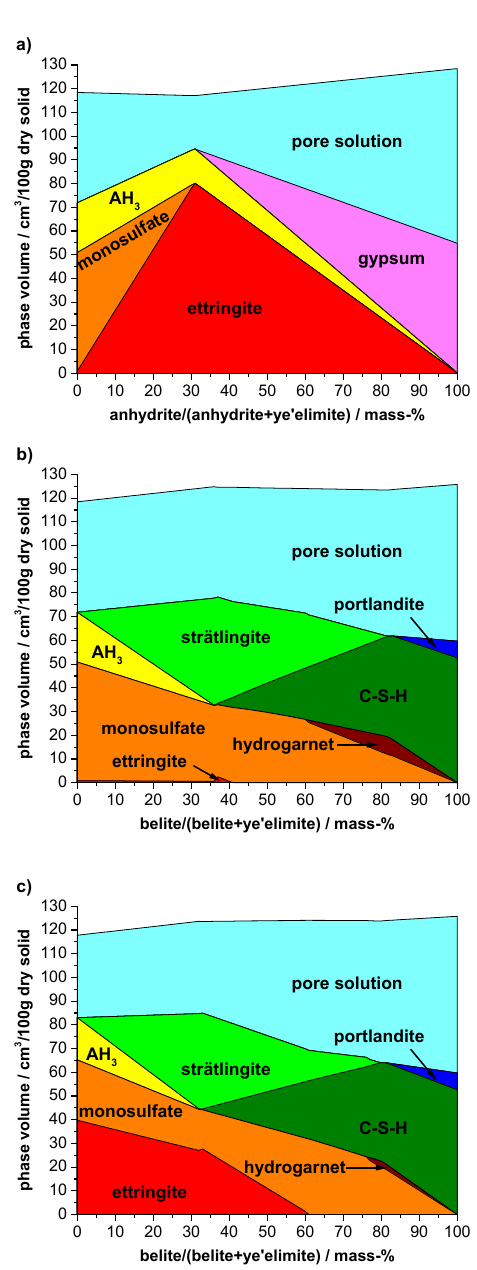
Figure 1. Calculated phase diagram of the thermodynamic stable hydrate assemblages in cm 3 per 100 g of dry solid of a) the system ye’elimite - anhydrite - water, b) the system ye’elimite - belite – water, and c) the system ye’elimite – calcium sulfate – belite – water at a fixed molar ratio anhydrite / ye’elimite of 0.8 (anhydrite / ye’elimite = 15:85 by mass). While monosulfate is a stable phase in the entire compositional range (with the exception of hydrated pure C 2 S), ettringite, which is occurring in very low amounts, is stable only at ye’elimite contents between 100 and 40 mass-% and is destabilised to monosulfate if sufficient calcium is available according to Eq. 5. Thus the hydrates in this binary system are determined to a large extent by